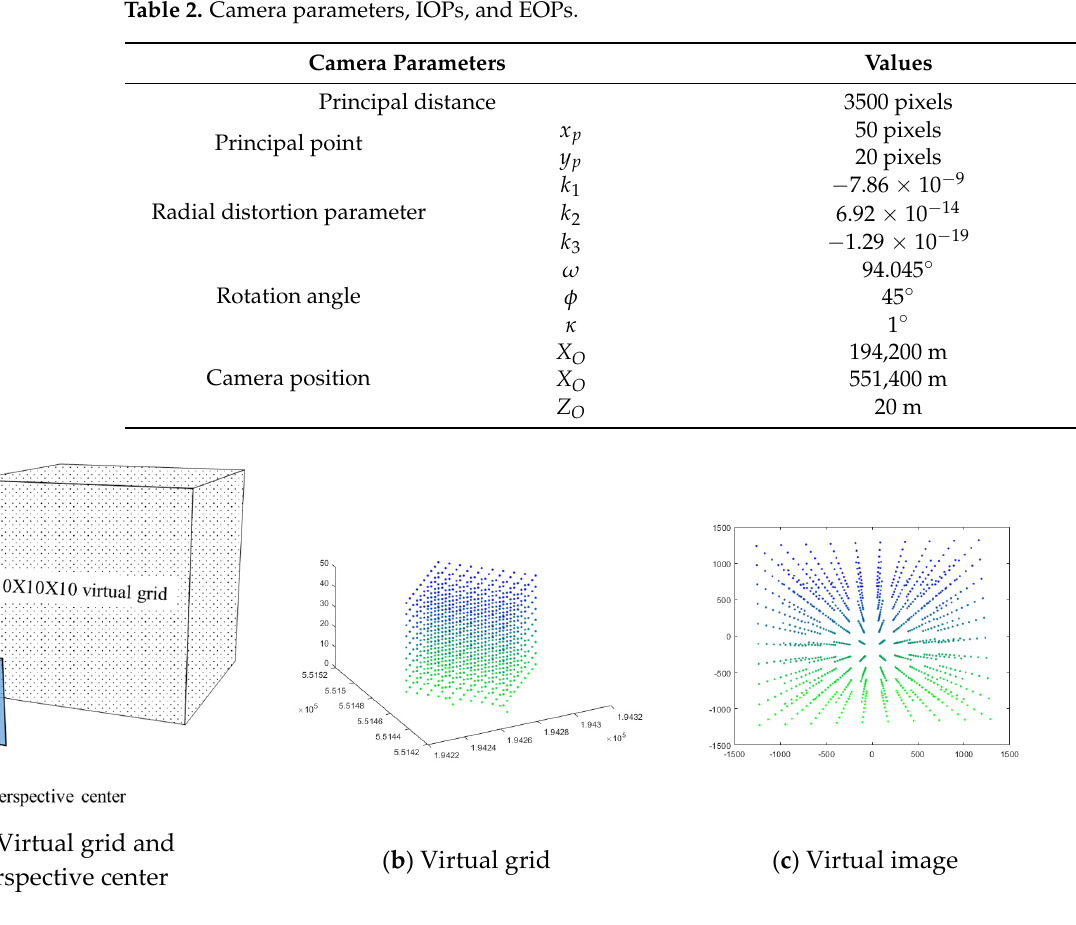
Figure 6. Virtual grid and virtual